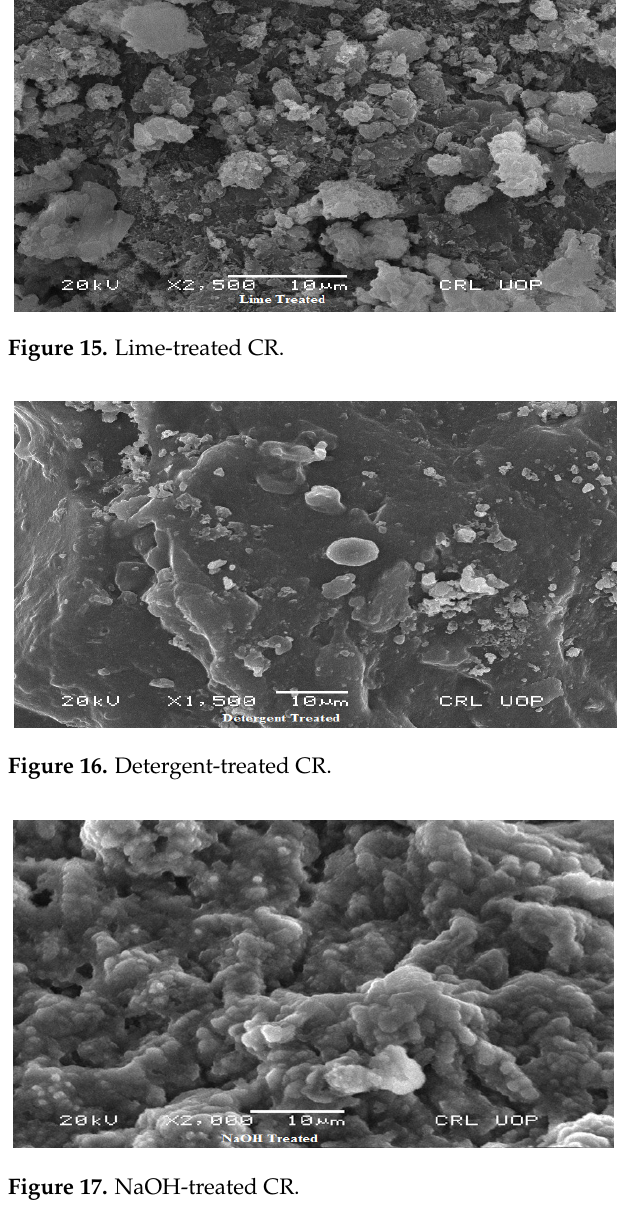
Figure 14. Water-treated CR.